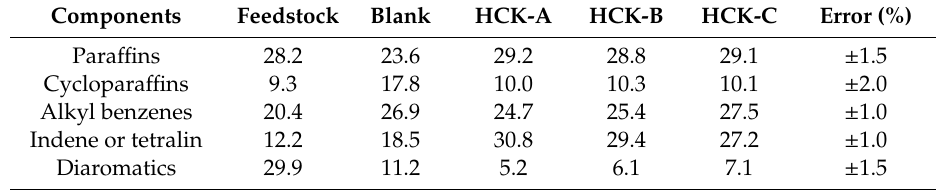
Table 2. Hydrocracking product distributions (wt.%) over the catalysts HCK-A, -B, and